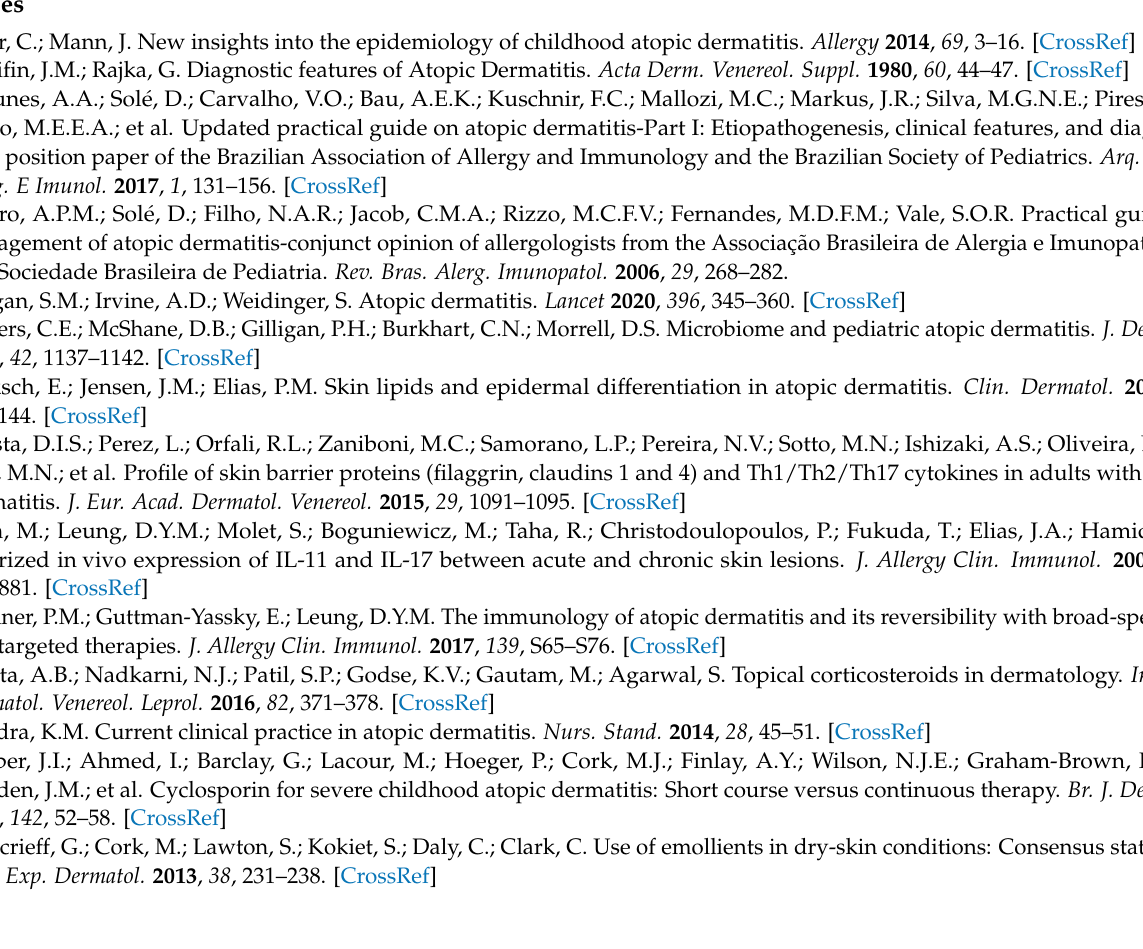
databases. Table S2: Apparent viscosity (30 s) and area of hysteresis of the creams as a function of storage time at room temperature. Table S3: Confounding variables taken into account in the distribution of groups. Table S4: Allergic comorbidities presented by patients included in the study. Figure S3: Sociodemographic and clinical